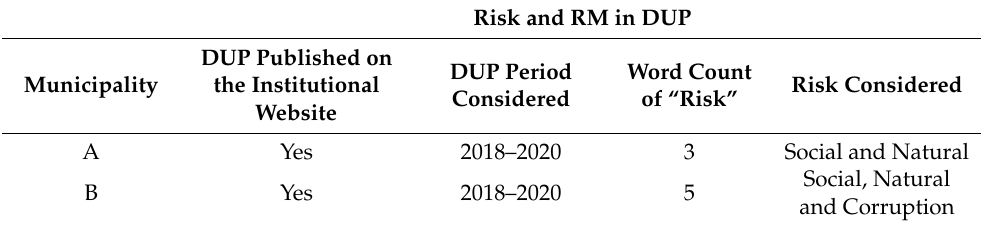
Table 3. Analysis of DUP in Municipalities A and B.